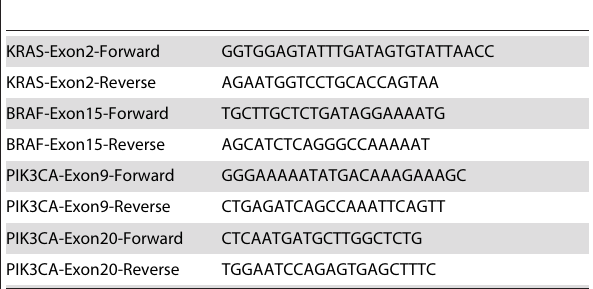
Table 3. The frequency of KRAS, BRAF and PIK3CA mutations according to different